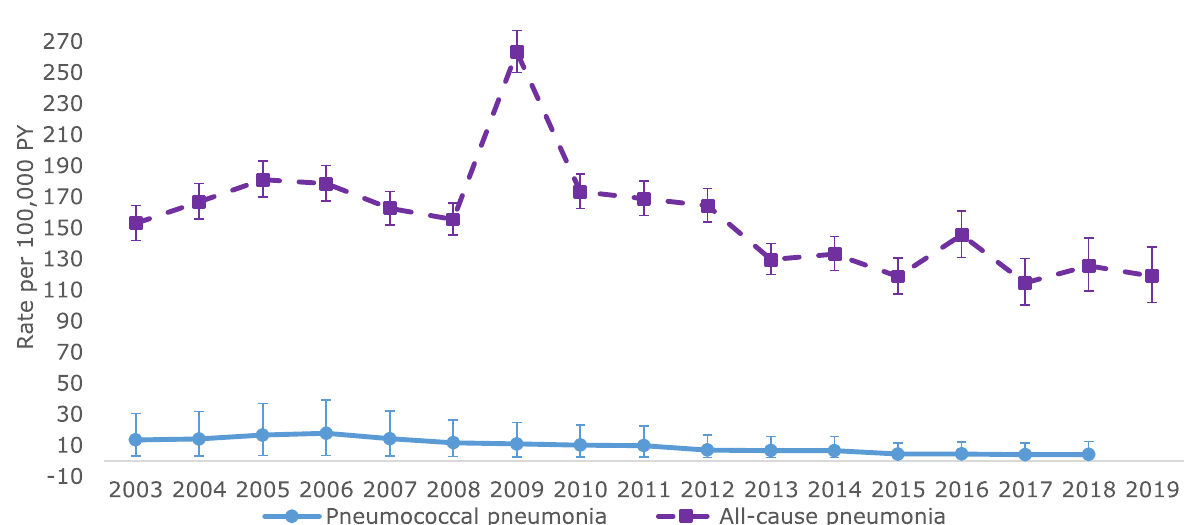
Fig. 1 PP and ACP IRs (per 100,000 PY) by study year (2003–2019). ACP: all-cause pneumonia; PP: pneumococcal pneumonia; PY: Person-Years